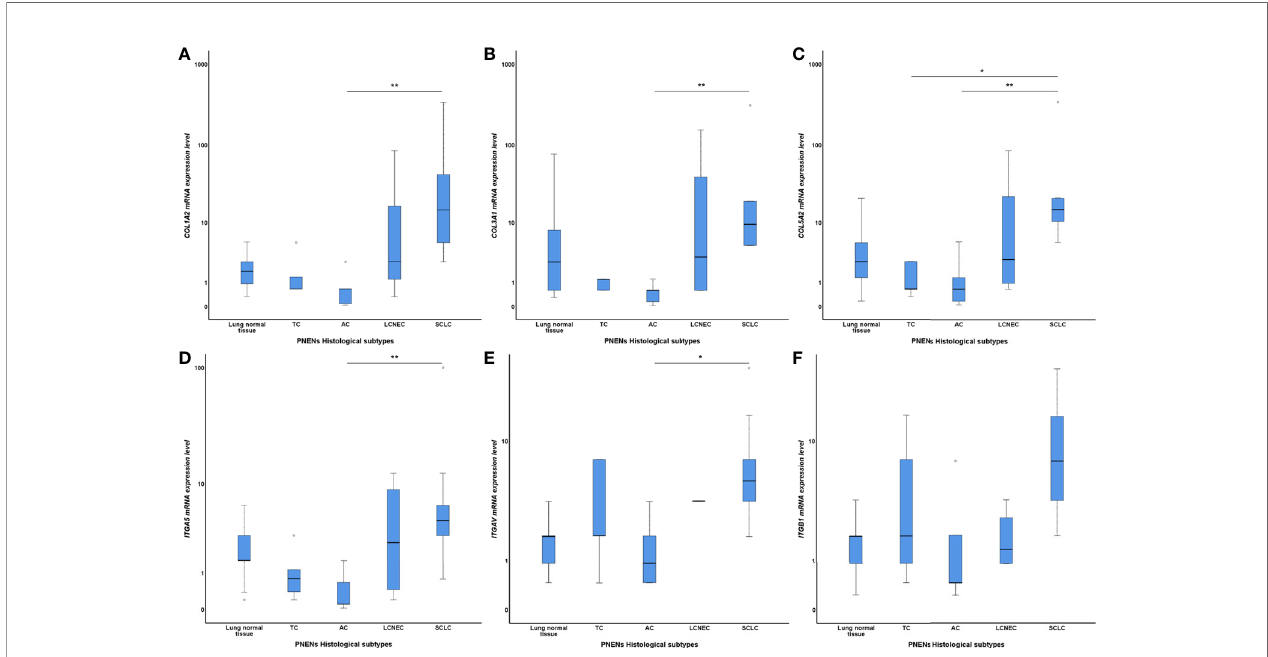
FIGURE 1 | Box plots of differentially expressed COL and ITG gene expressions among PNENs histological subtypes in a log scale. The top and bottom of the box plot represents the 25th and 75th percentile range. The line across the box shows the median of gene expression and the top and bottom bars show the maximum and minimum values, outliers were showed. The association between COL and ITG gene expressions and PNENs histological types was calculated by non-parametric Kruskal-Wallis test. (A) Difference of COL1A2 mRNA expression level among PNENs histological subtypes (P=0.004; Adjusted P-value [AC-SCLC]=0.007); (B) Difference of COL3A1 mRNA expression level among PNENs histological subtypes (P=0.004; Adjusted P-value [AC-SCLC]=0.004); (C) Difference of COL5A2 mRNA expression level among PNENs histological subtypes (P=0.003; Adjusted P-value [AC-SCLC]=0.010; Adjusted P-value [TC-SCLC]=0.019); (D) Difference of ITGA5 mRNA expression level among PNENs histological subtypes (P=0.009; Adjusted P-value [AC-SCLC]=0.008); (E) Difference of ITGAV mRNA expression level among PNENs histological subtypes (P=0.028; Adjusted P-value [AC-SCLC]=0.018); (F) Difference of ITGB1 mRNA expression level among PNENs histological subtypes (P=0.057). The horizontal bars represents the statistical difference between groups, the pairwise comparison was adjusted by Bonferroni ’ s correction for multiple tests (Adjusted P-value). (*) was used when P > 0.05, and (**) was used when P ≥ 0.01. SCLC, small cell lung carcinoma; LCNEC, large cell neuroendocrine carcinoma; AC, atypical carcinoid; TC, typical